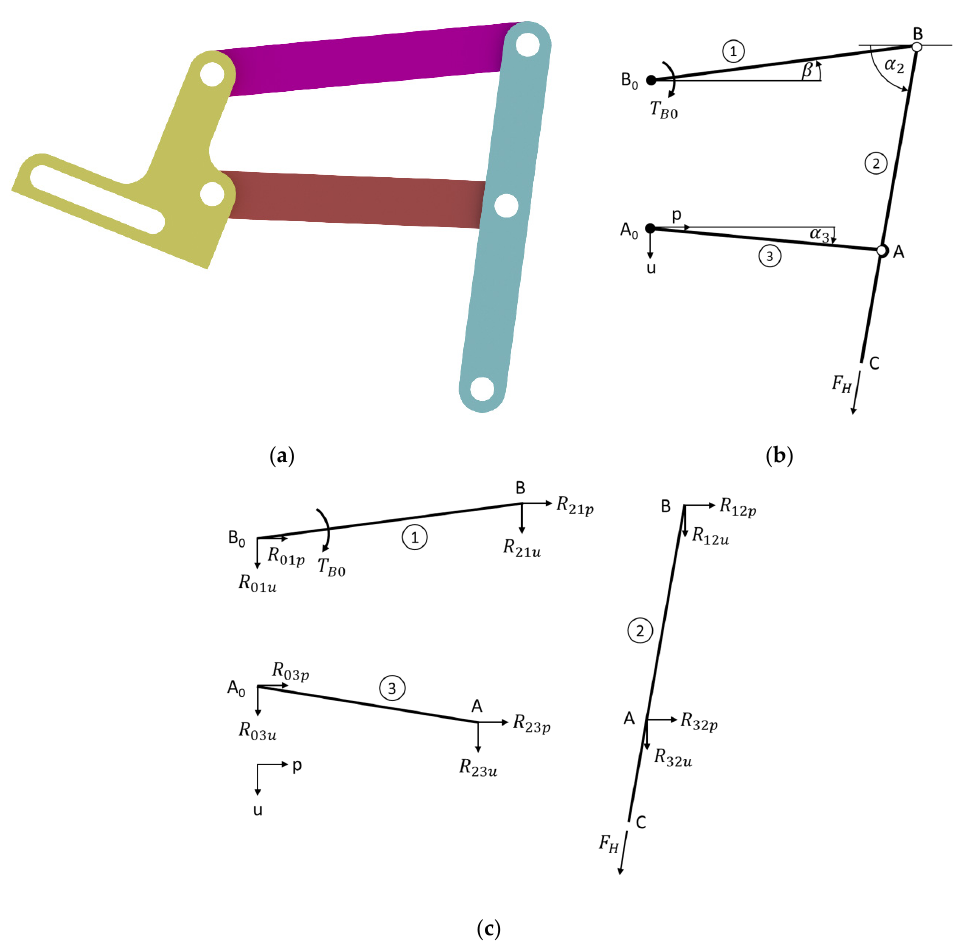
Figure 14. Schemes for force distribution analysis: ( a ) a CAD front view of the second linkage (A0AB0B); ( b ) an overall free body diagram; ( c ) free body diagrams of single